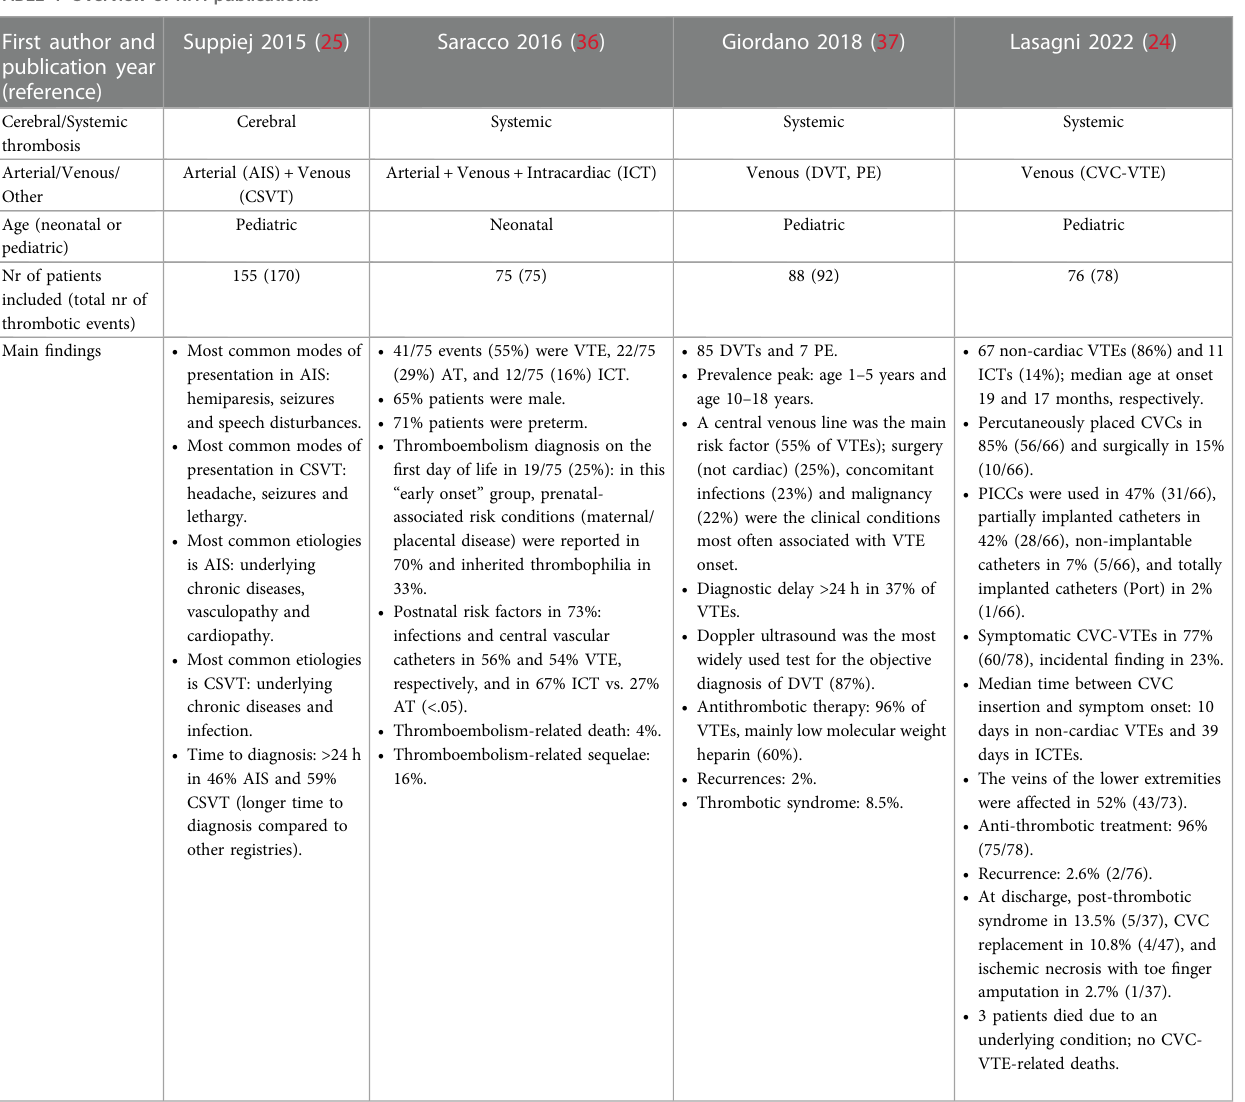
TABLE 4 Overview of RITI